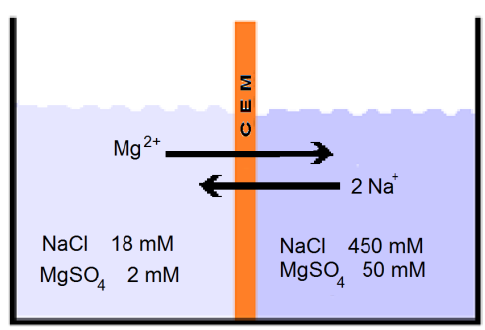
Figure 1. Principle of uphill transport of magnesium ions.